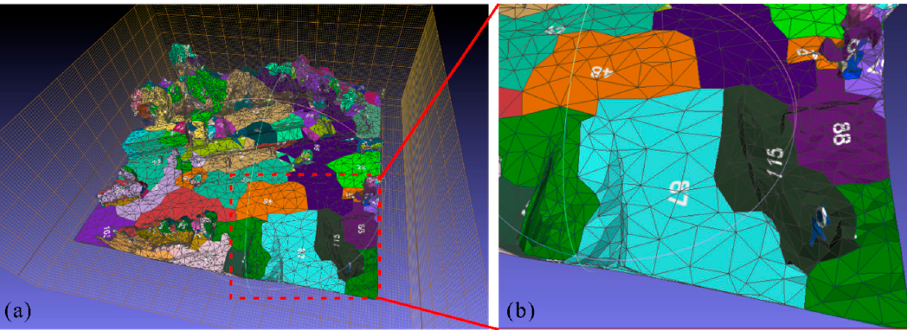
Figure 7. Best view IDs of the original mesh facets: ( a ) whole drawing; ( b ) partial enlarged drawing.